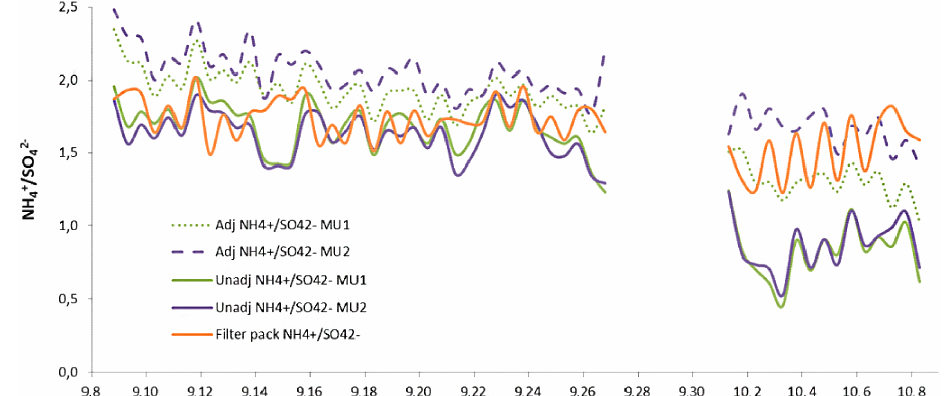
Figure 17. Ammonium sulfate ratios (NH +